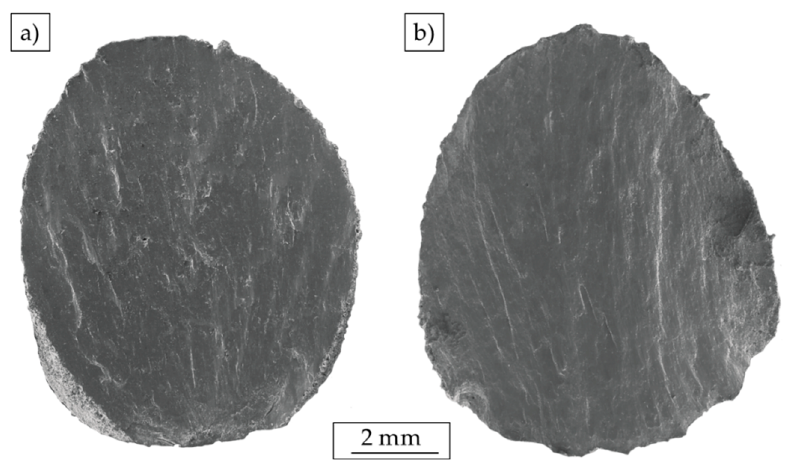
Figure 20. SEM images of fractured specimens tested at 400 MPa in air at RT: ( a ) batch A Mg (N f = 23,192 cycles) and ( b ) batch B Mg (N f = 102,848 cycles).